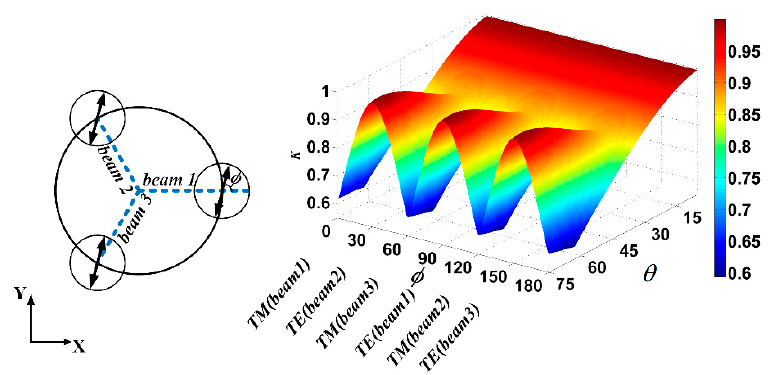
Figure 6. On the left is a top view of three beams incident, and the arrows represent the polarization direction of the beams on the x-y plane. The figure on the right shows that the maximum co-directional polarization component is still applicable to the small-angle incident situation of multi-beam interference. However, as the incident angle increases, the stability of the multi-beam interference system will be very poor.